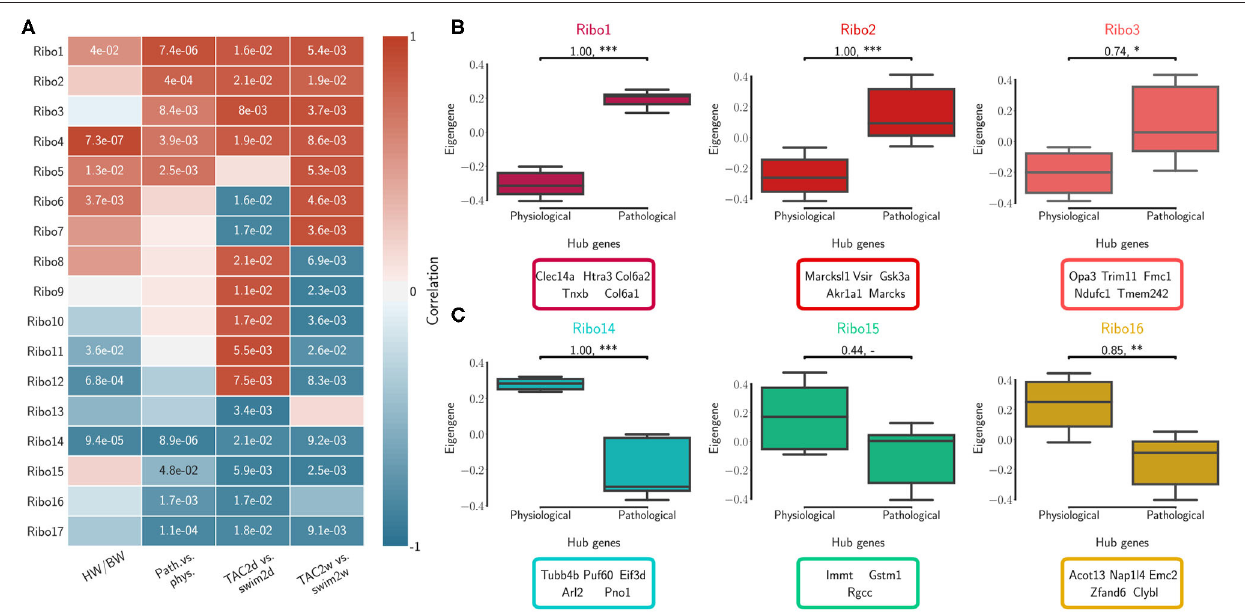
FIGURE 3 | Translatome (Ribo) network modules were clustered to assess relatedness based on correlation of co-expressed eigengenes. (A) Biweight midcorrelation and Student correlation p -values between eigengene module expression and disease association as well as heart-weight-to-body-weight ratio. (B) The first three module expression profiles and top ranked hub genes that are positively correlated with pathological cardiac remodeling. (C) The first three module expression profiles and top ranked hub genes that are negatively correlated with pathological cardiac remodeling (i.e., positively correlated with the physiological model). Significance was measured using a one-sided Mann-Whitney U -test, at a threshold of * < 0.05 (** < 0.01, *** < 0.001, p -values may be affected by the small sample size, for this reason we also report effect size using non-directional rank-biserial correlation). Up to five hub genes are